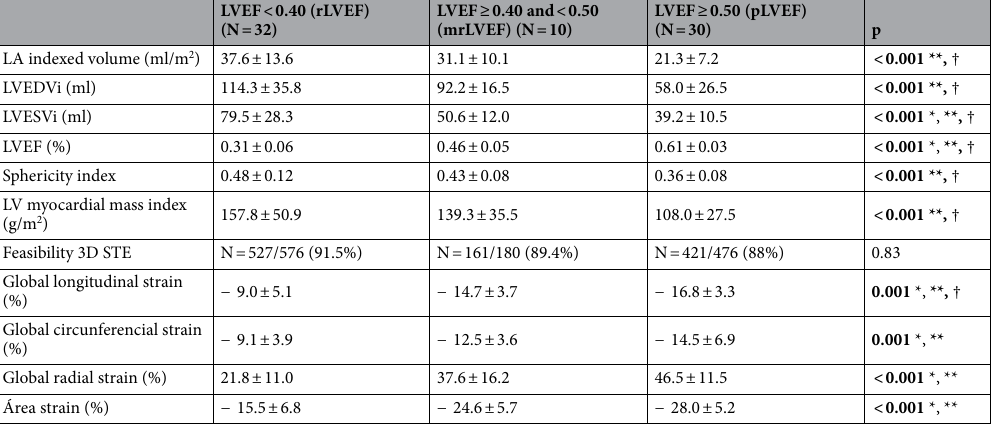
Table 4. Conventional and STE parameters by 3D Echo according to the LVEF. Significant values are in bold. * LA Left atrium, LVEF Left ventricle ejection fraction, LVEDVi Indexed Left ventricle end diastolic volume, LVESVi Indexed Left ventricle end systolic volume. *rLVEF × mrLVEF, p < 0.05, **rLVEF × pLVEF, p < 0.05, †mrLVEF × pLVEF, p < 0.05. rLVEF reduced left ventricular ejection fraction, mrLVEF mid-range or mildly ejection fraction, pLVEF preserved left ventricular ejection fraction.